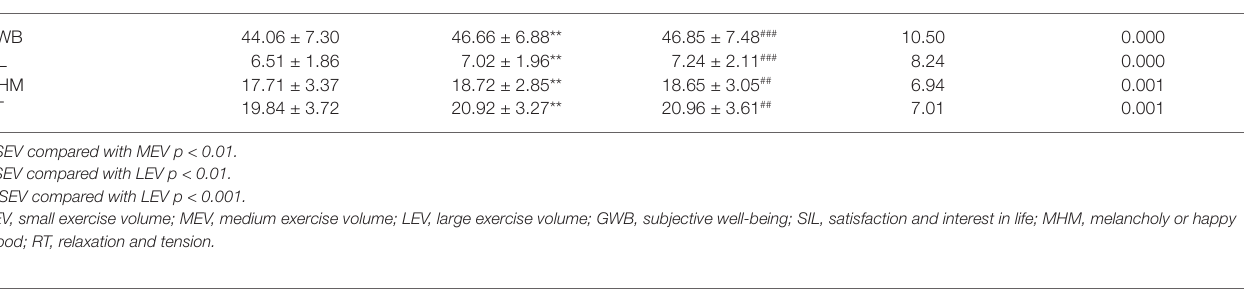
TABLE 4 | Regression analysis of physical exercise, body image, self-esteem, and subjective well-being in college students ( N = 671).